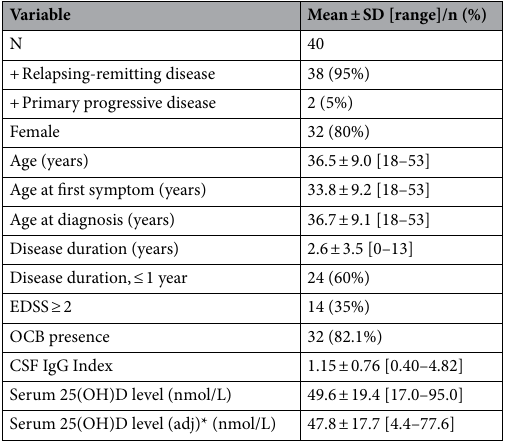
Table 1. Summary characteristics of MS patients. *Adj. serum 25(OH)D levels adjusted for seasonal